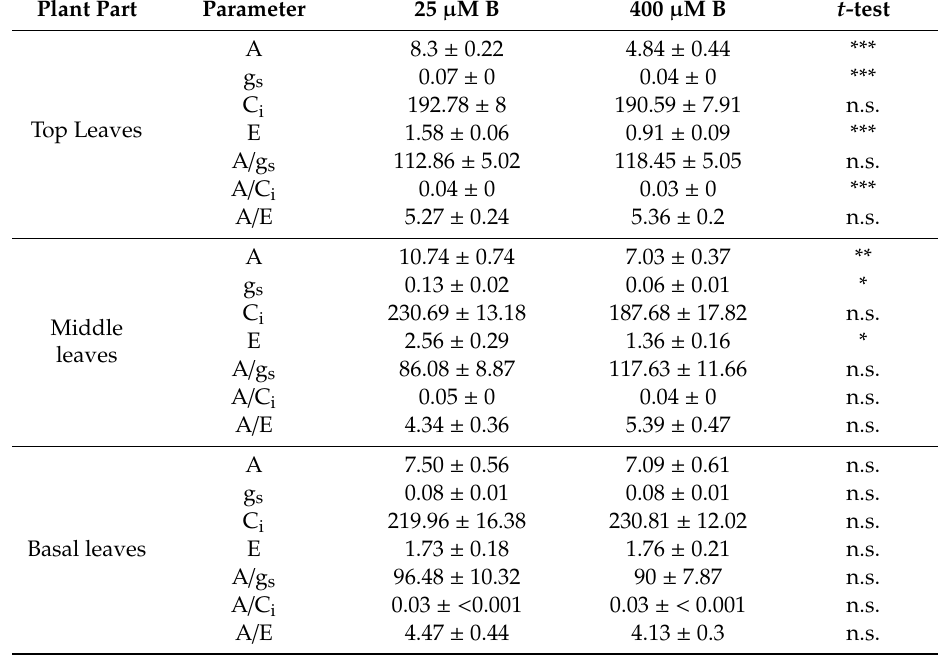
Table 3. Net photosynthesis (A; µ mol CO 2 m − 2 s − 1 ), stomatal conductance (g s ; mmol H 2 O m − 2 s − 1